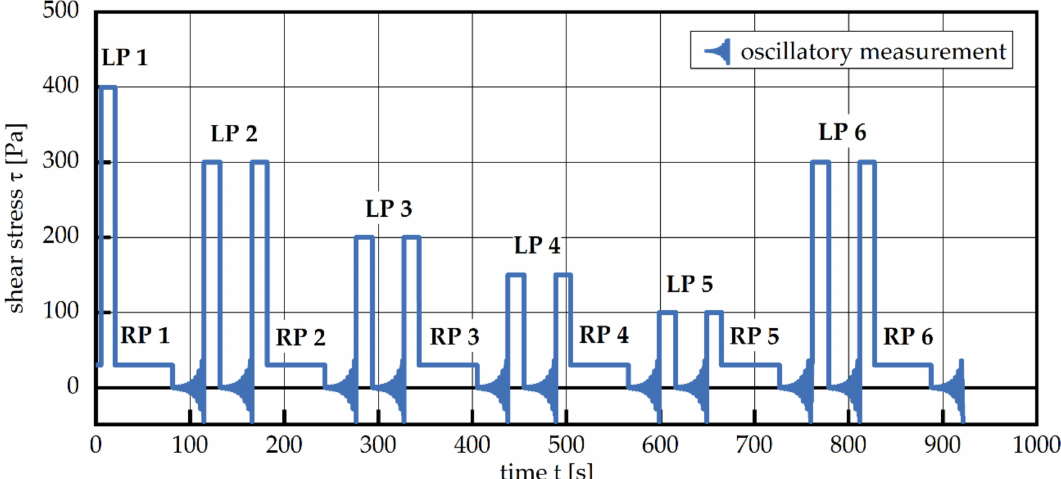
Figure 1. The rheometer measurement sequence consisting of loading phases (LPs) characterized by high stress levels and recovery phases (RPs) with low stress levels. Oscillatory measurements in between loading and recovery phases are employed in order to determine the structural strength; for details see text. The stress value of the oscillatory measurement cannot be quantified in this figure. Five consecutive loading phases (LPs) with decreasing levels ( τ LP1 = 400 Pa, τ LP2 = 300 Pa,